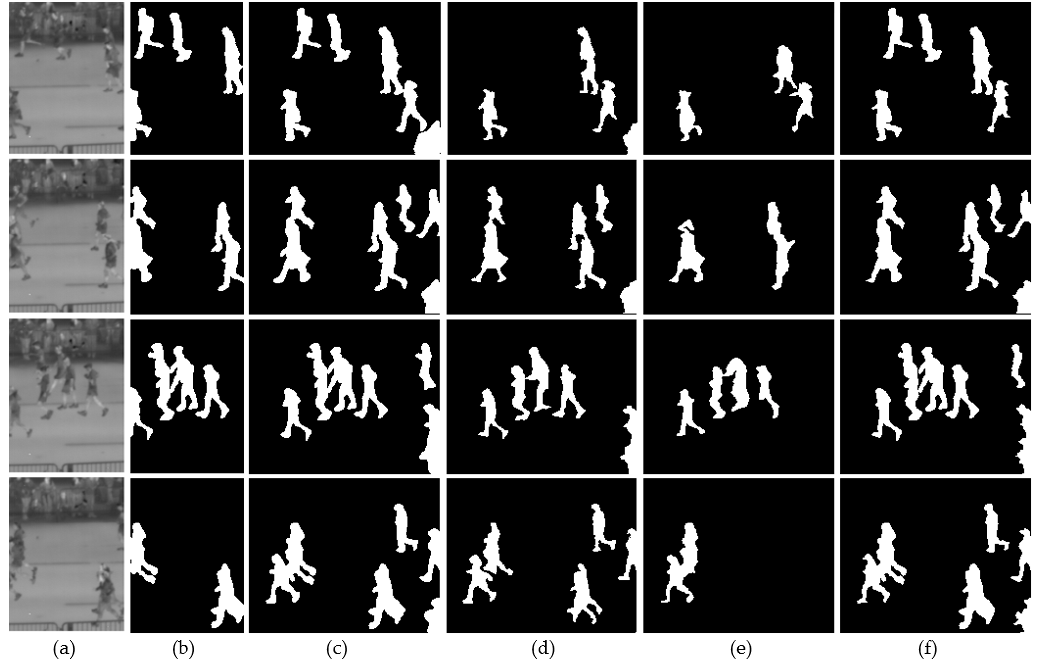
Figure 14. Comparisons of detection results using original images, GT images, and the predicted images obtained by the state-of-the-art methods and the proposed method: ( a ) original images; detection results using ( b ) original images and ( c ) GT images of Figures 11b–13b; and the images predicted by ( d ) Haziq et al. [26], ( e ) Liu et al. [17], and ( f ) the proposed method.